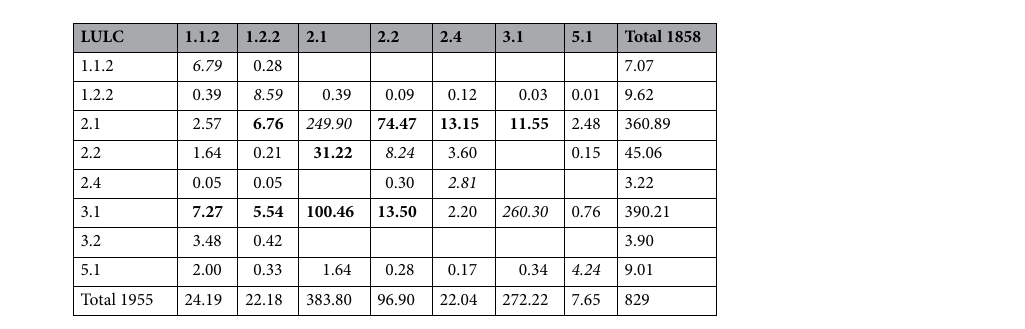
Figure 8. LULC maps of the Kestel region in: ( a ) 1858, ( b ) 1955, ( c ) 2020.